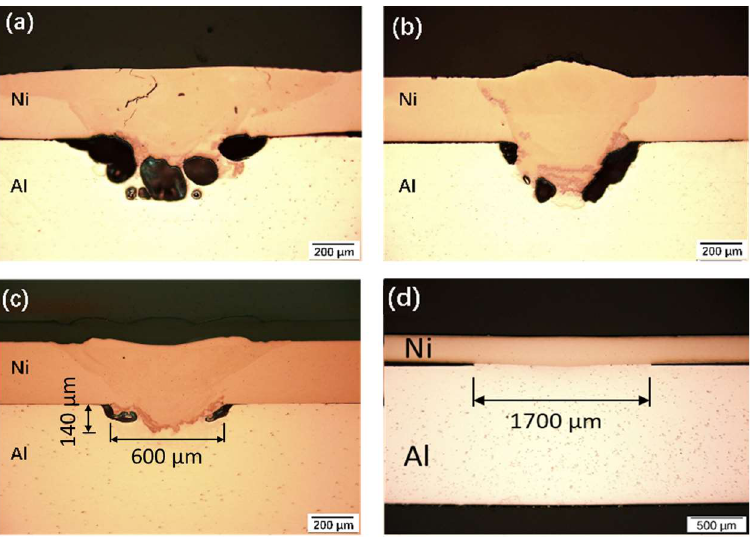
Figure 3. Macro view of the laser welded Ni to Al: ( a ) PW (150 W), ( b ) CW (1800 W, focal point position 0), ( c ) PW (120 W) and ( d ) CW (1800 W, focal point position +5 mm).